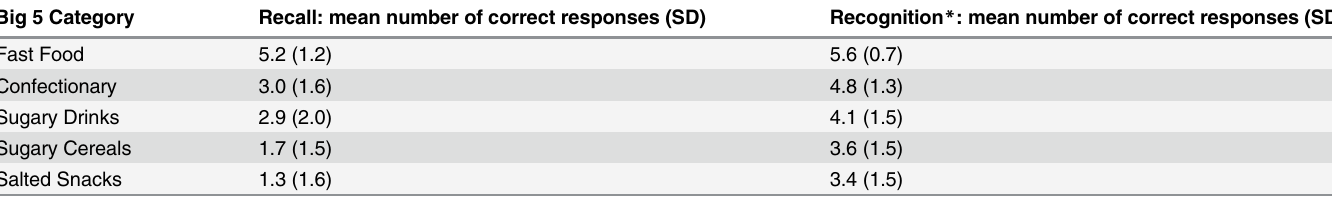
Table 2. Mean number of correct responses and mean score of responses for the recall and recognition tasks for each of the ‘ big 5 ’ categories. Big 5